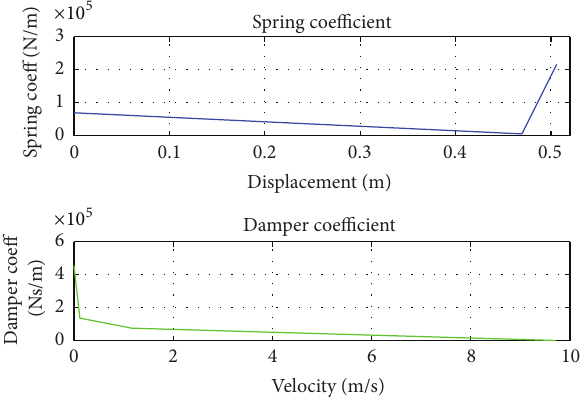
Figure 15: The nonlinear damper and spring characteristics. Table 5: Parameters found through the Firefly